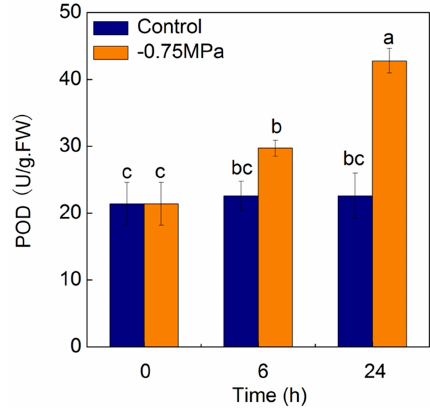
Figure 9. Effects of sorbitol treatment on peroxidase (POD) activity. Values are means and bars indicate SDs ( n = 6). Columns with different letters indicate significant difference by Duncan’s multiple range tests at p < 0.05.